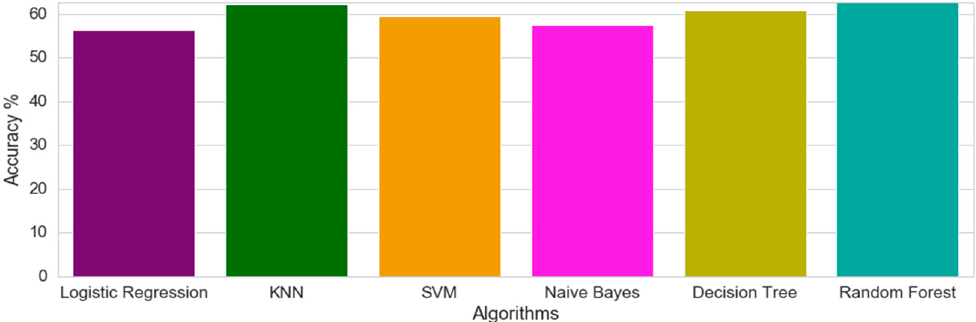
Figure 13. The random forest accuracy (identified as score), based on the estimators’ numbers.